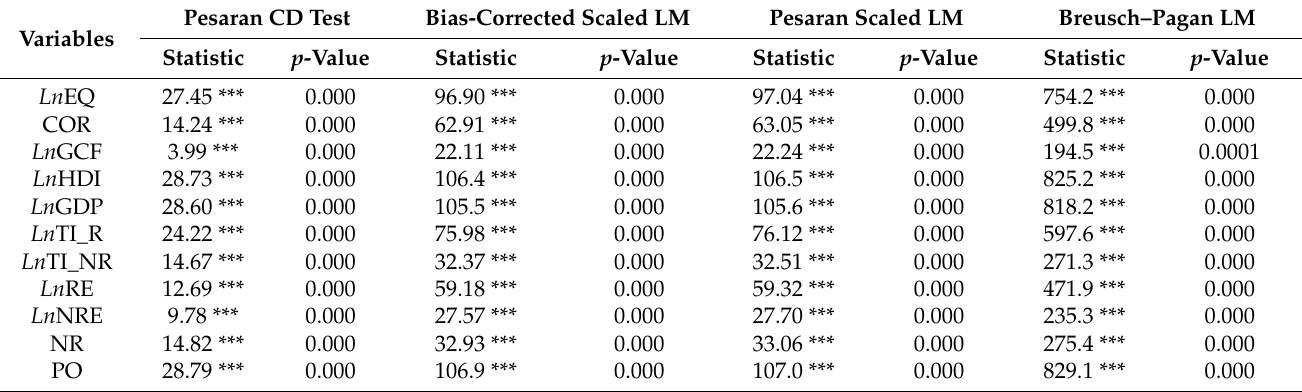
Table 3. Cross-dependency test results.